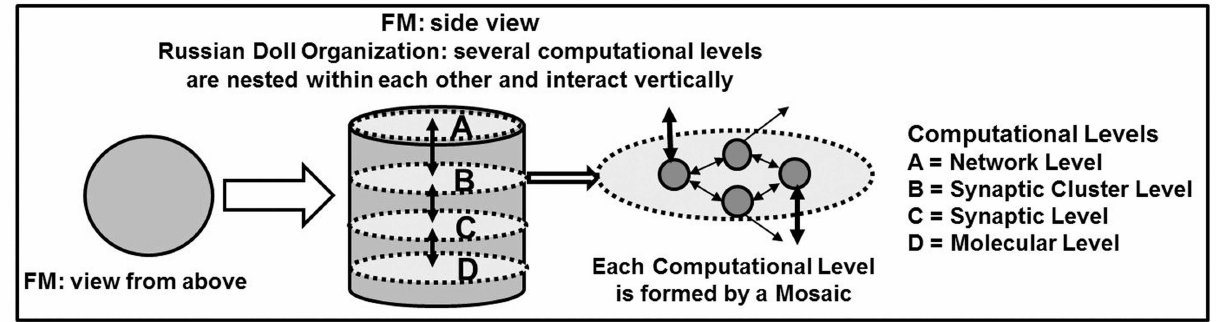
FIGURE 3 |A schematic representation of the functional module (FM) as a basic structure of the Russian Doll organization of the central nervous system (CNS) .The three-dimensional elaboration of the information inside